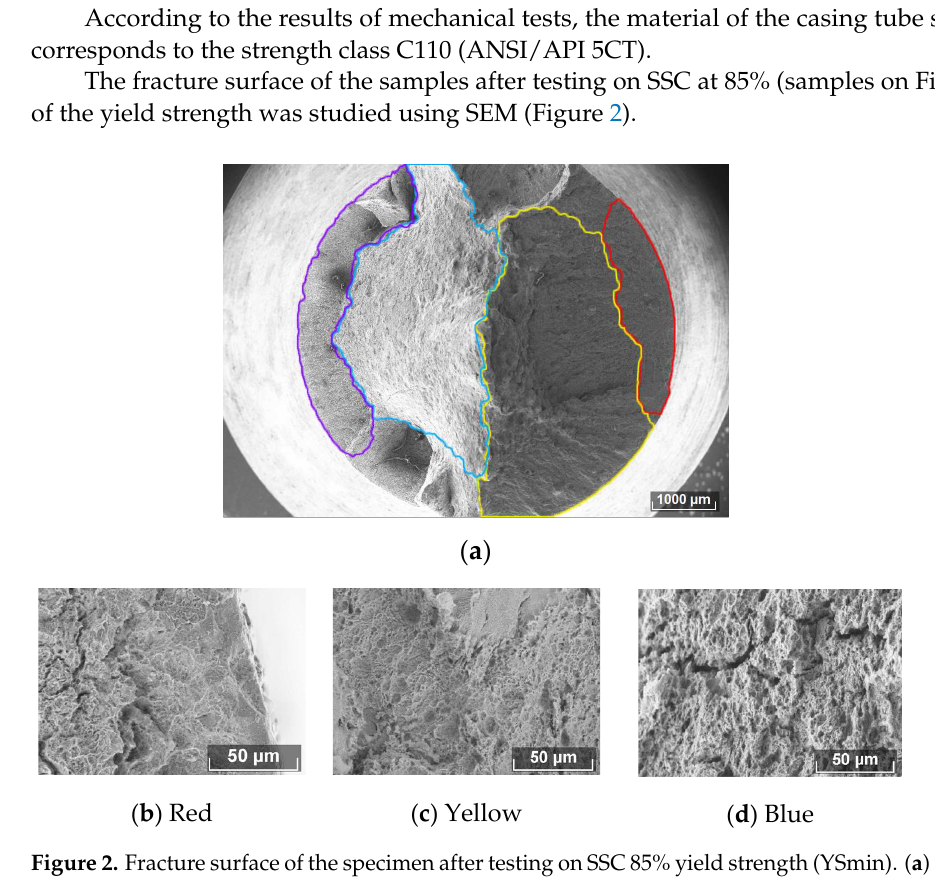
Figure 2. Fracture surface of the specimen after testing on SSC 85% yield strength (YSmin). ( a ) General view of the fracture surface, ×10; ( b – d ) enlarged images, respectively, in the red, yellow and blue regions, ×2000.